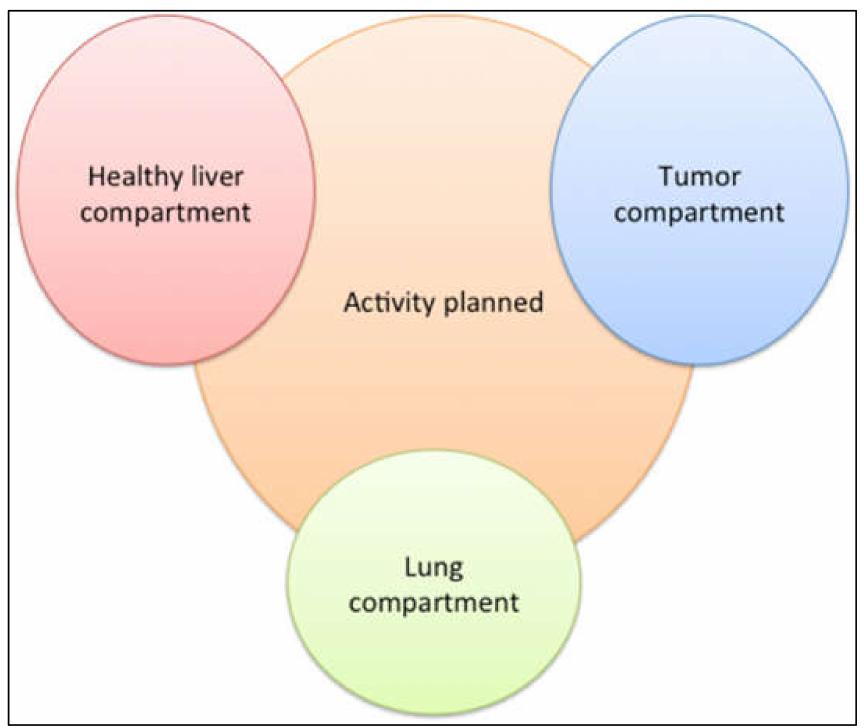
Figure 1. Multi-compartment dosimetry (partition model) using technetium-99m macro-aggregated albumin single-photon emission computed tomography combined with computed tomography for activity planning. The absorbed doses in these different compartments can be simulated before treatment and enable optimization of the activity